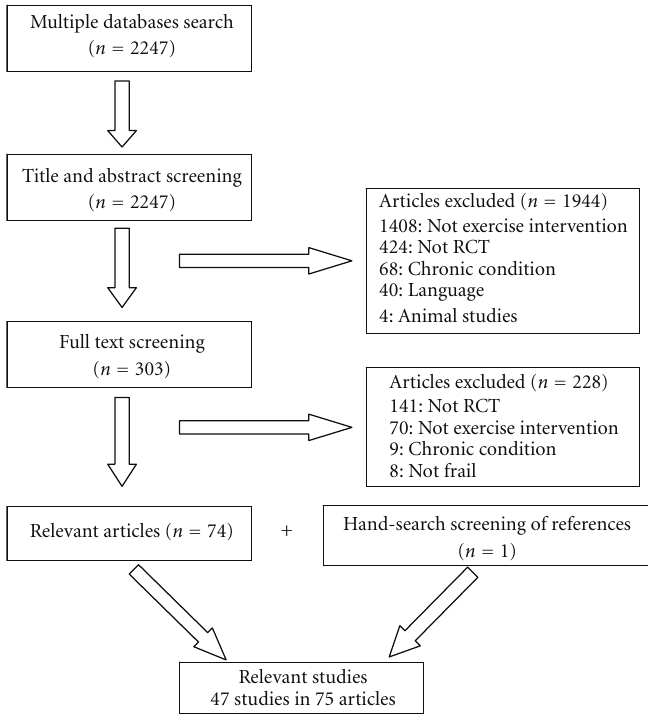
Figure 1: Flow chart of article screening. RCT : randomized controlled